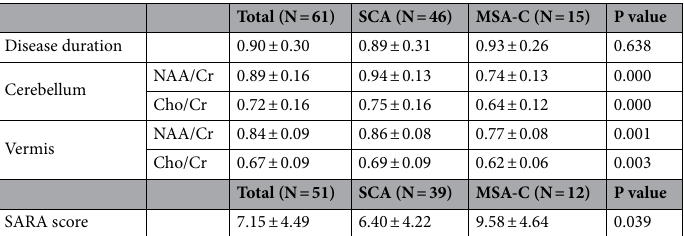
Table 4. The differences of parameters between HCBS negative patients with MSA-C and SCA with a disease duration within 1 year. Mann–Whitney test. Numeric data are presented as mean ± standard deviation. HCBS hot cross bun sign; MSA-C multiple system atrophy, cerebellar type; SCA spinocerebellar ataxia; SARA Scale for the Assessment and Rating of Ataxia; NAA N -acetyl aspartate; Cr creatinine; Cho